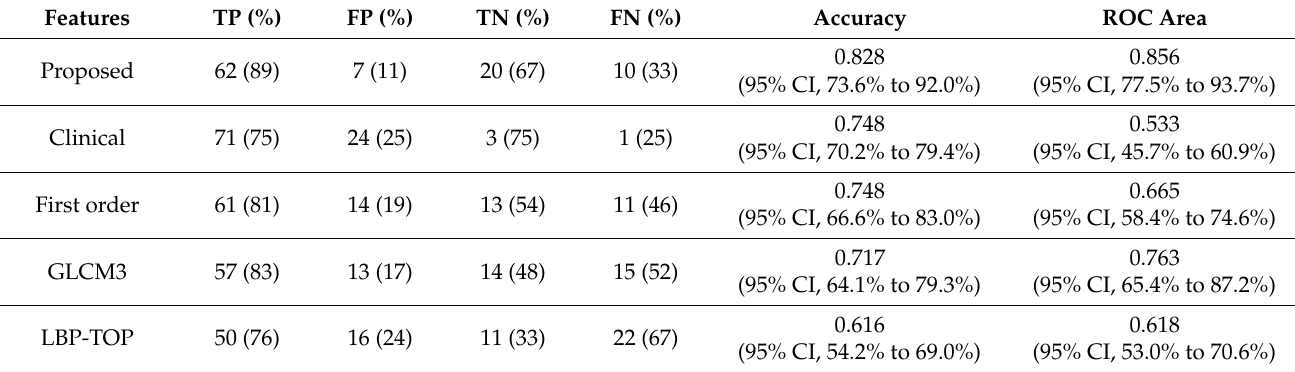
Table 4. Metrics that describe the various accuracies considering each feature class stand alone and the proposed approach, obtained by the combination of all the features